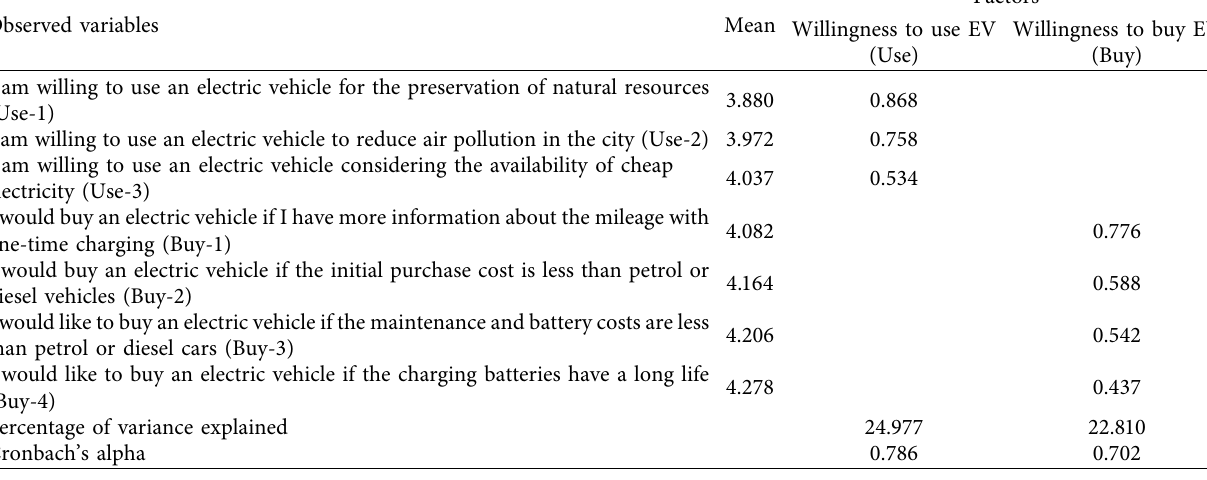
Table 4: Rotated factor loadings of willingness to buy and use EV.